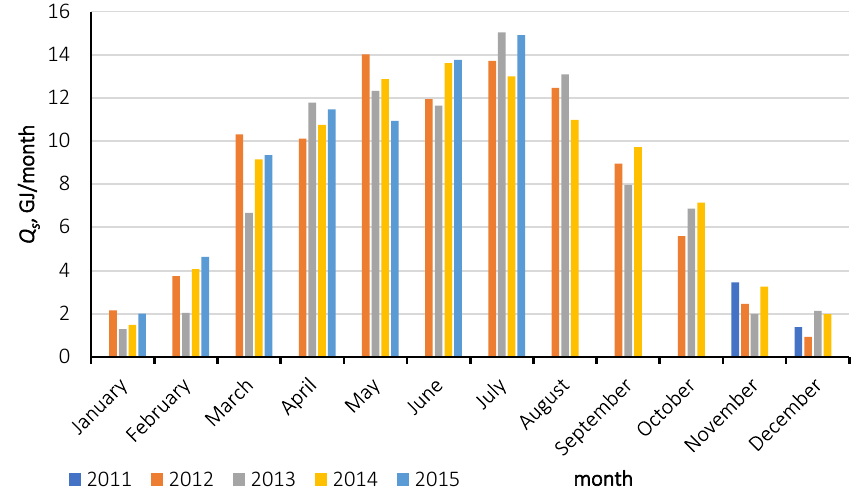
Figure 6. Monthly values of solar heat gains ( Q s ) obtained from the installation in Krosno from November 2011 to July 2015.